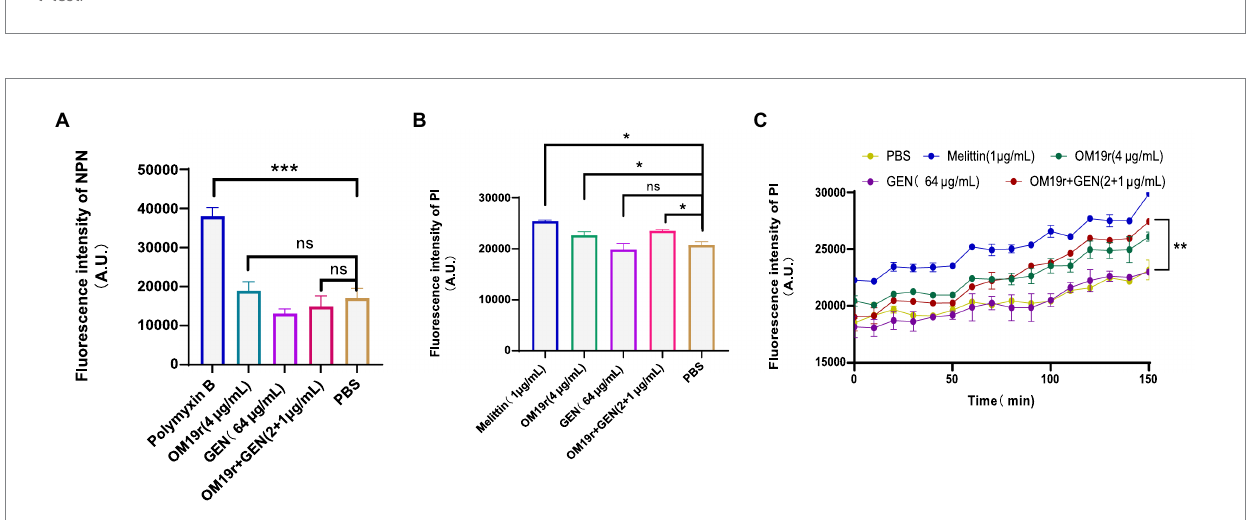
FIGURE 4 Effect of OM19r combined with GEN on membrane permeability of E. coli B2. (A) Outer membrane permeability of E. coli B2 was measured by NPN probe at 30 min. (B) , Inner membrane permeability of E. coli B2 was measured by PI probe at 30 min. (C) Inner membrane permeability of E. coli B2 was measured by PI probe, fluorescence intensity was detected after every 10 min for 150 min. Graphs show mean of three biological replicates, p-values were determined using an unpaired two-tailed Student’s t